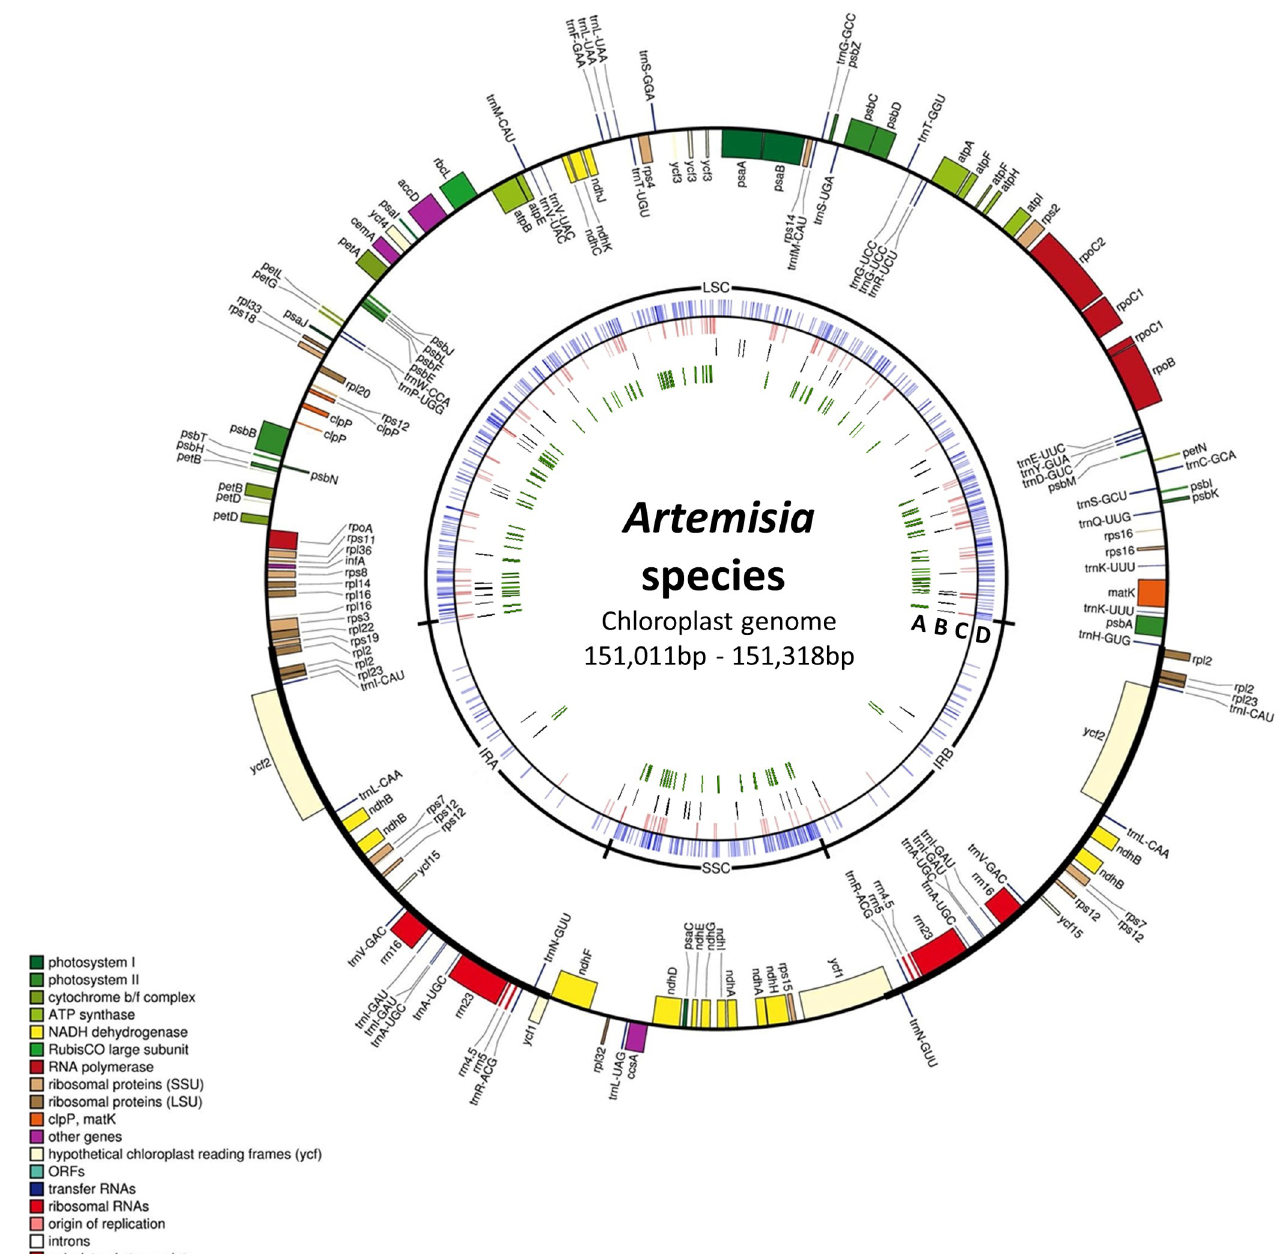
Fig 1. Chloroplast genome maps of A . gmelinii , A . capillaris , and A . fukudo . Genes represented on the outside of the outer circle are transcribed clockwise, and those shown on the inside of the outer circle are transcribed counterclockwise. Genes belonging to the same functional group were indicated in the same color. The inner tracks represent inter- and intraspecific variations. Track A and B are intraspecific variations of A . gmelinii and A . capililaris , respectively. Track C and D indicate total SNPs and InDels among five Artemisia chloroplast genomes, respectively.